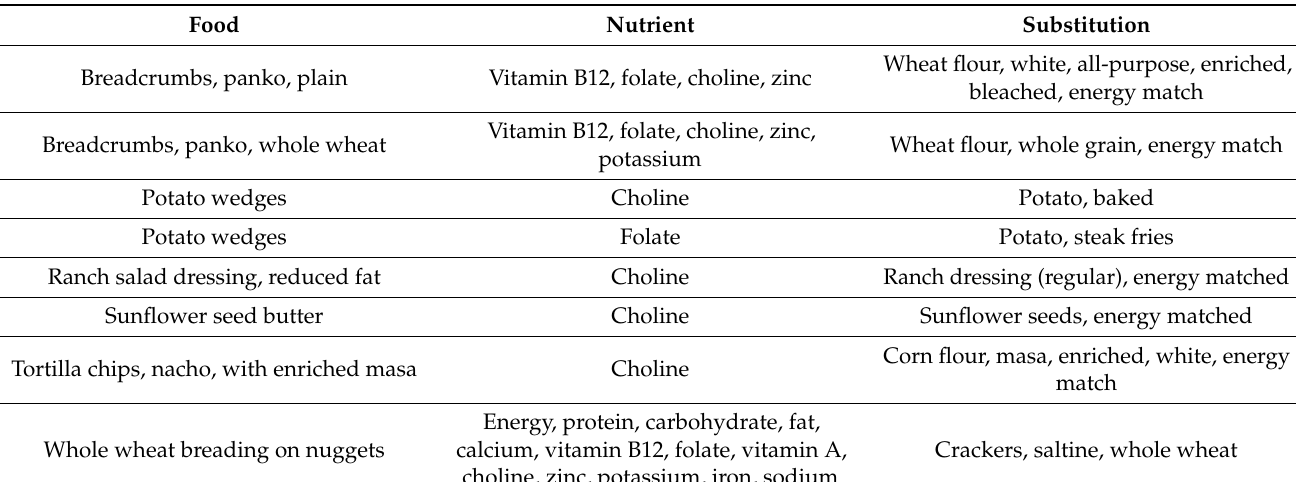
Table A1. Micronutrient substitution